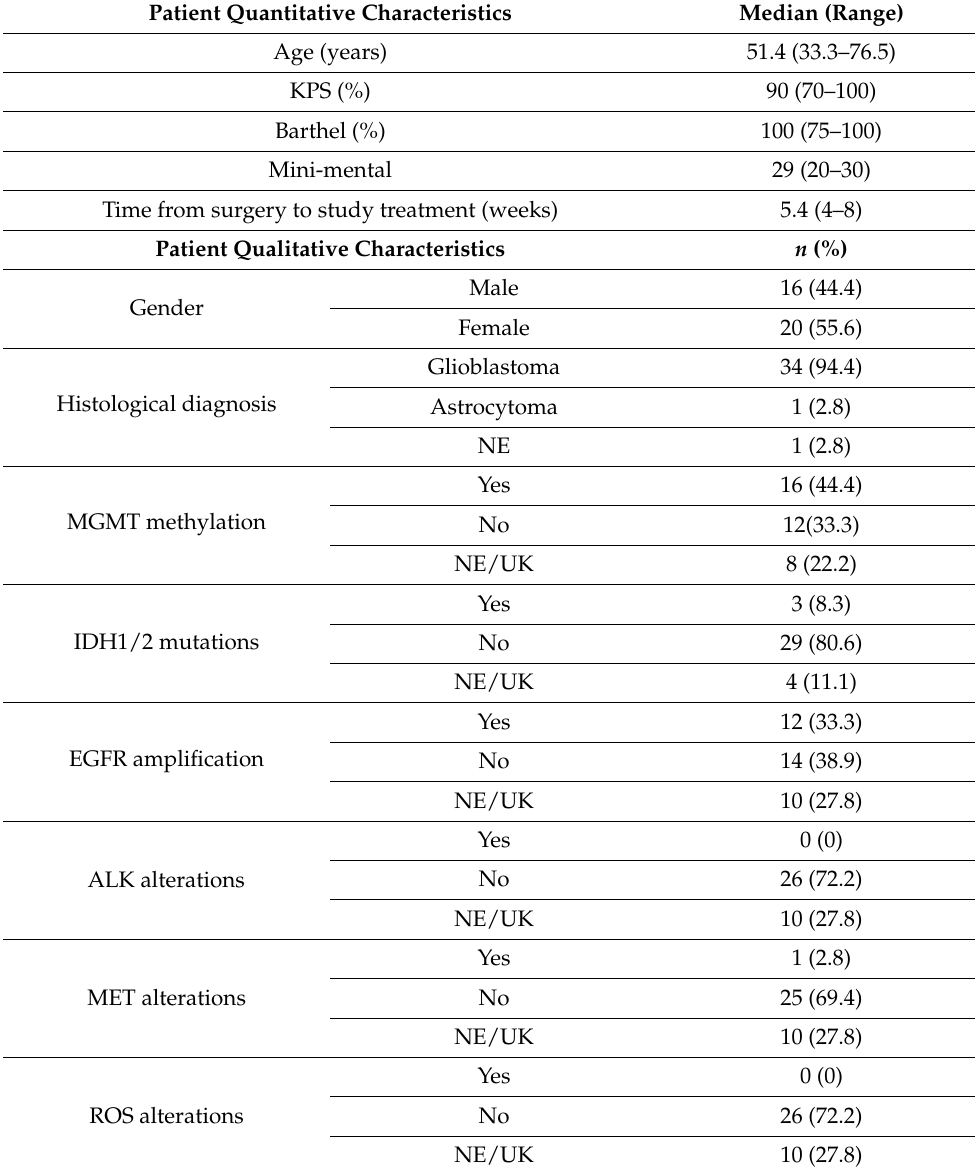
Table 1. Patient characteristics per protocol cohort ( n =